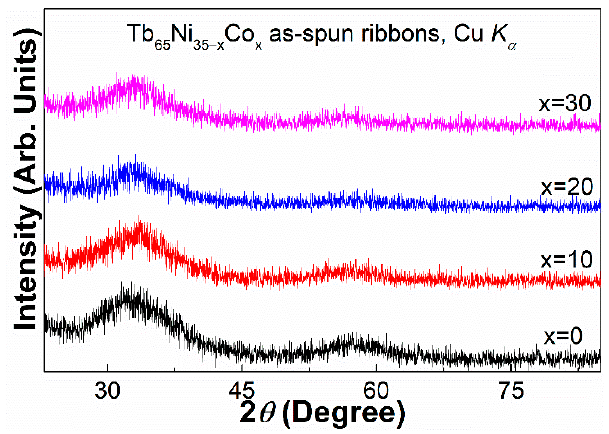
Figure 1. XRD patterns of the Tb 65 Ni 35 − x Co x (x = 0, 10, 20, 30) as-spun ribbons.